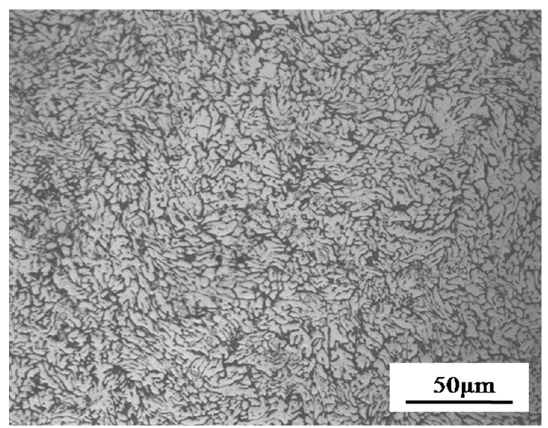
Figure 2. Microstructures of as-rolled NiTiNb SMA.